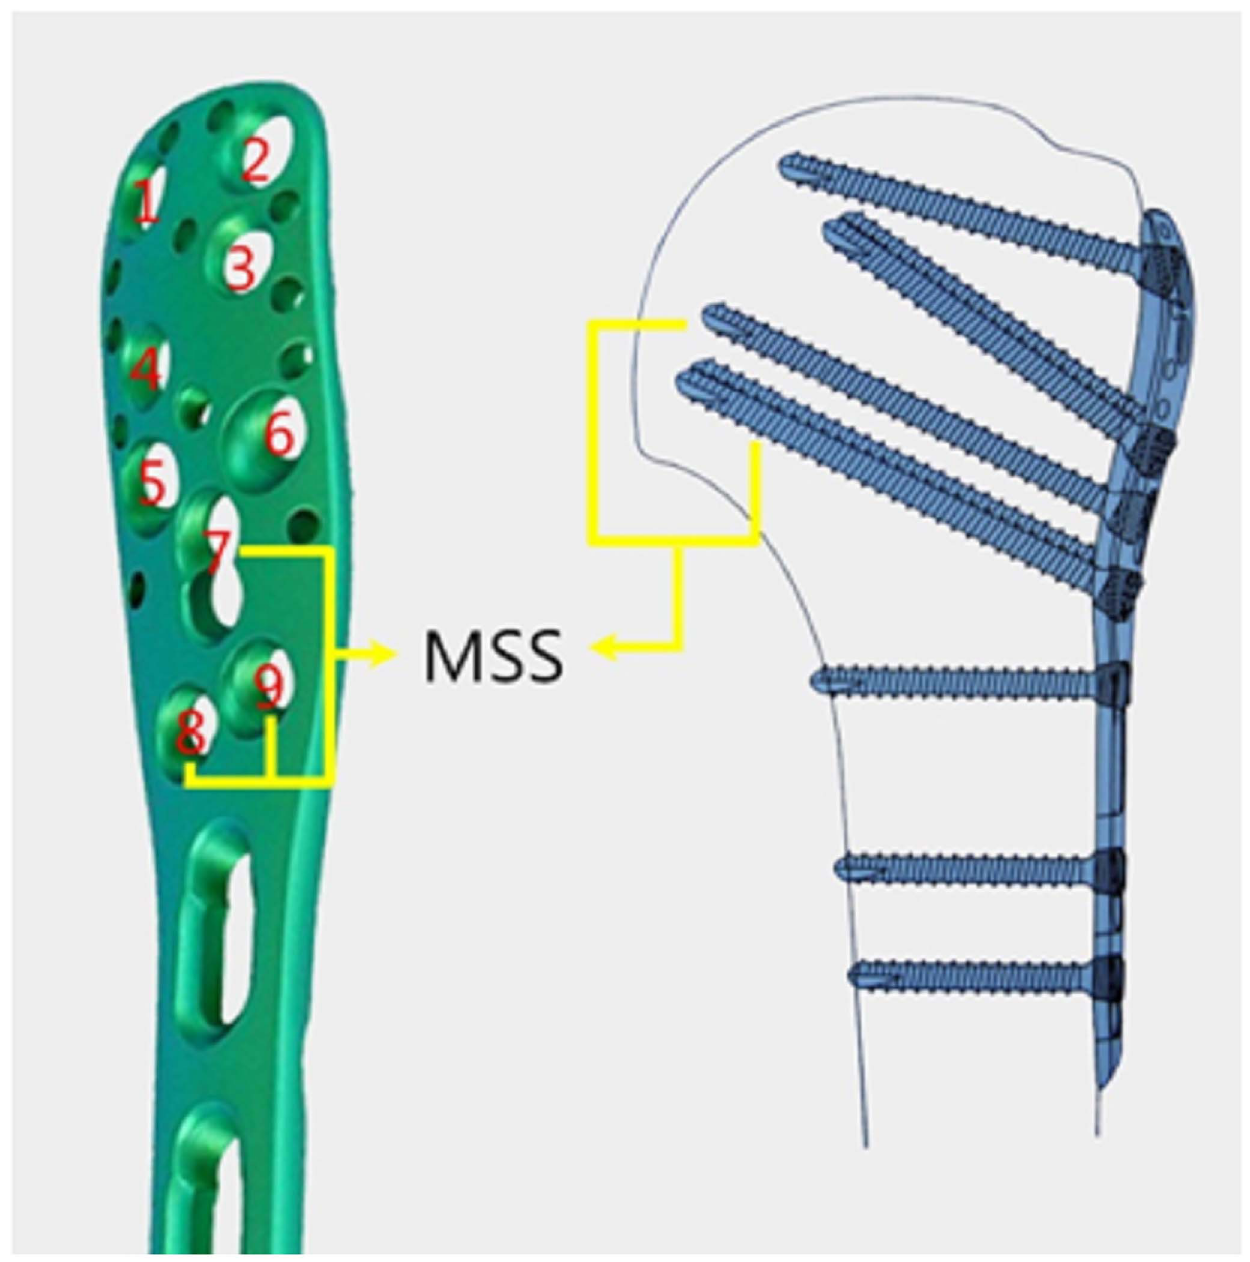
Figure 1. The proximal screw distribution and the medial support screws (MSS) for the locking proximal humerus plate.